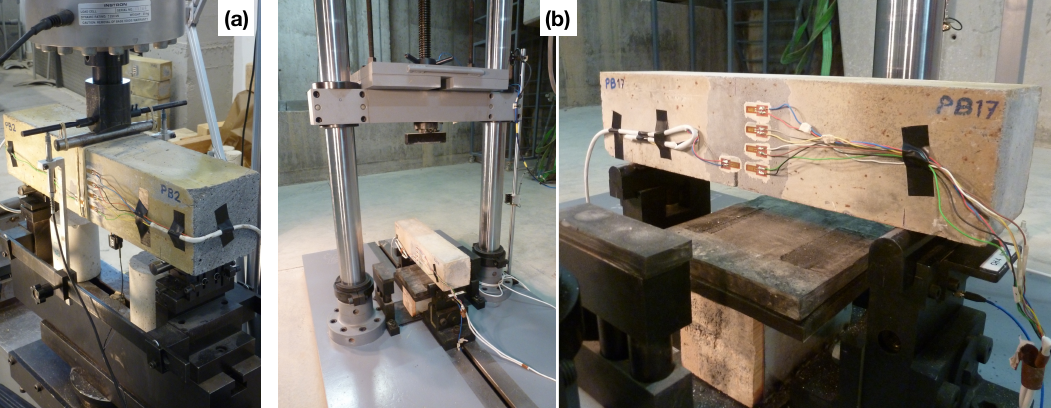
Figure 2. ( a ) A beam prepared for testing using the servo-hydraulic testing machine; and ( b ) experimental set-up using the drop-weight impact device, the strain gages were connected to the individual channels of the data acquisition